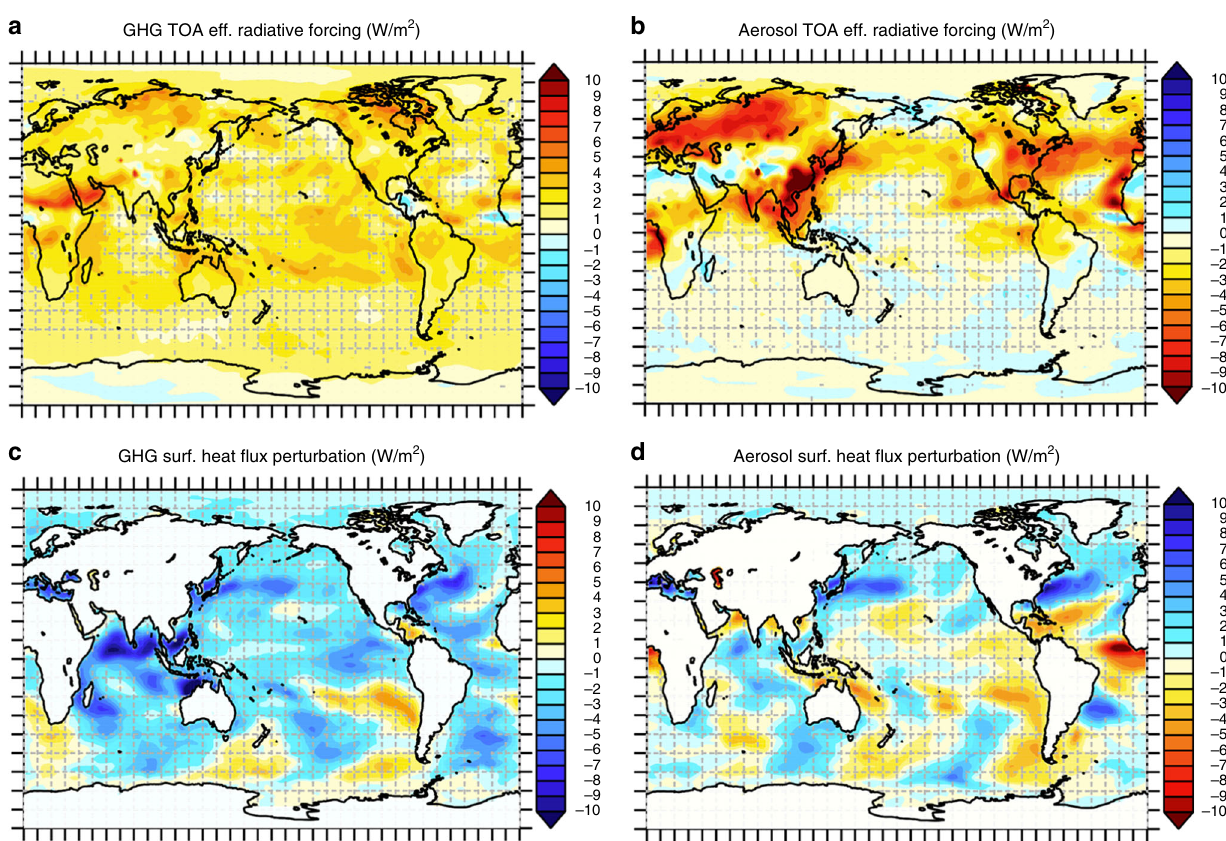
Fig. 2 Spatial similarities in top-of-atmosphere (TOA) and surface forcing. a , b June – July – August (JJA)-mean TOA effective radiative forcing due to a greenhouse gases (GHGs) and b aerosols. c , d JJA-mean surface heat fl ux perturbation due to c GHGs and d aerosols. Note that the color palette for aerosol signals ( b , d ) is reversed relative to that for GHG signals ( a , c ). Gridded regions are not statistically signi fi cant at the 95% con fi dence level via t -test. See Supplementary Fig. 1 for December – January – February-mean